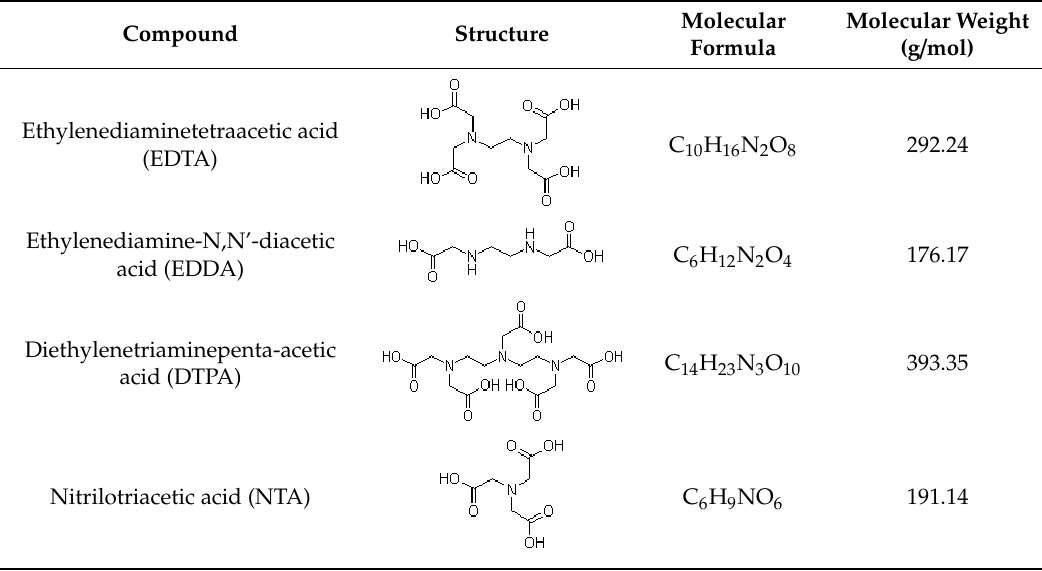
Table 1. Formula and structure of the different chelating agents tested.